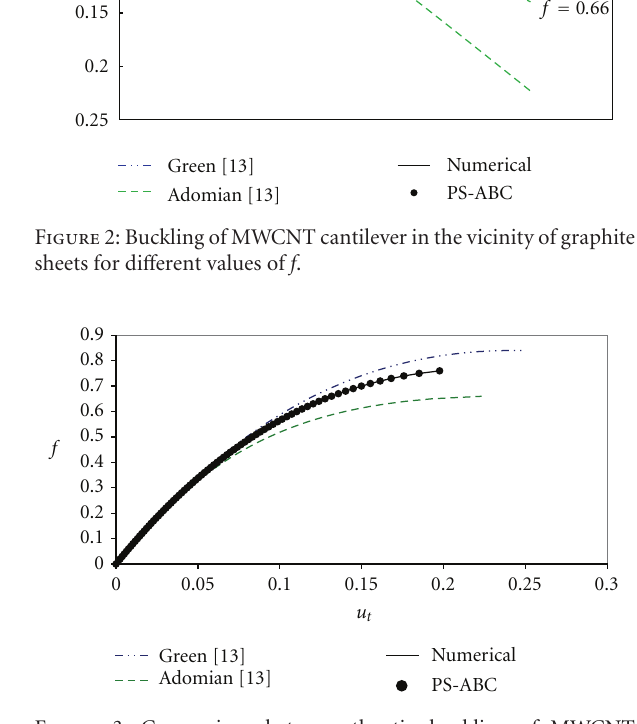
Figure 3: Comparison between the tip buckling of MWCNT cantilevers obtained by di ff erent